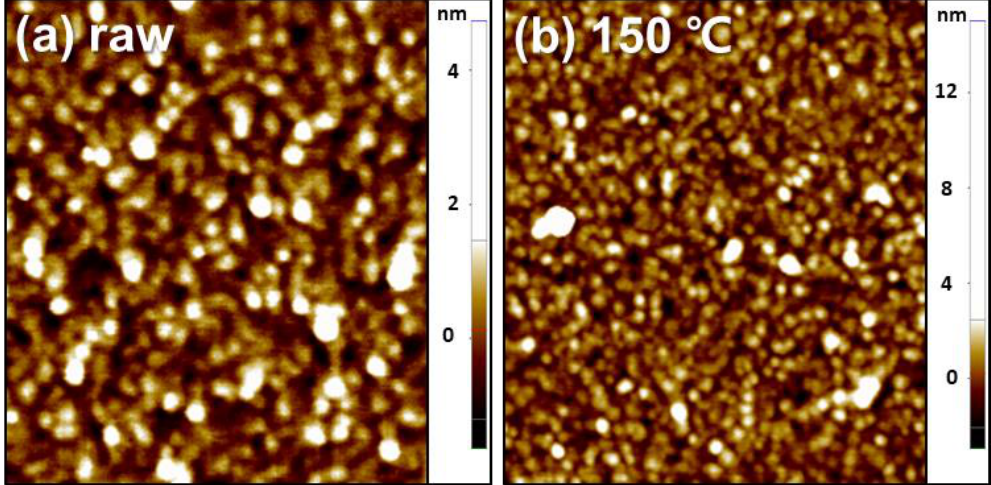
Figure 3. Atomic force microscopy (AFM) images of the tri-layer Au / Fe / Au metal catalyst with Fe encapsulation before ( a ) and after ( b ) the annealing process.